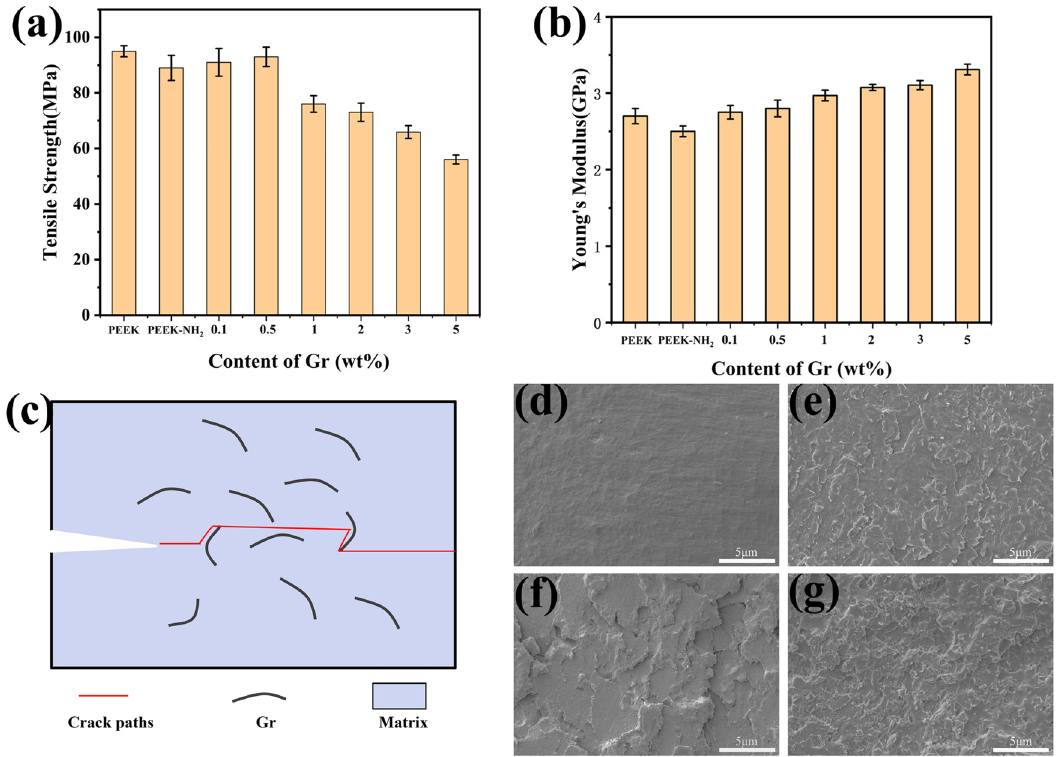
Figure 6: ( a ) Tensile strength and ( b ) modulus of PEEK, PEEK - NH 2 , and PEEK - NH 2 /GN composites, ( c ) schematic illustration of crack propagation mechanism in PEEK - NH 2 /GN composite, ( d ) SEM images from tensile fracture surfaces of PEEK - NH 2 , ( e ) PEEK - NH 2 /0.5 wt% GN, ( f ) PEEK - NH ( g ) PEEK - NH 2 /1 wt% GN, and 2 /3 wt% GN.